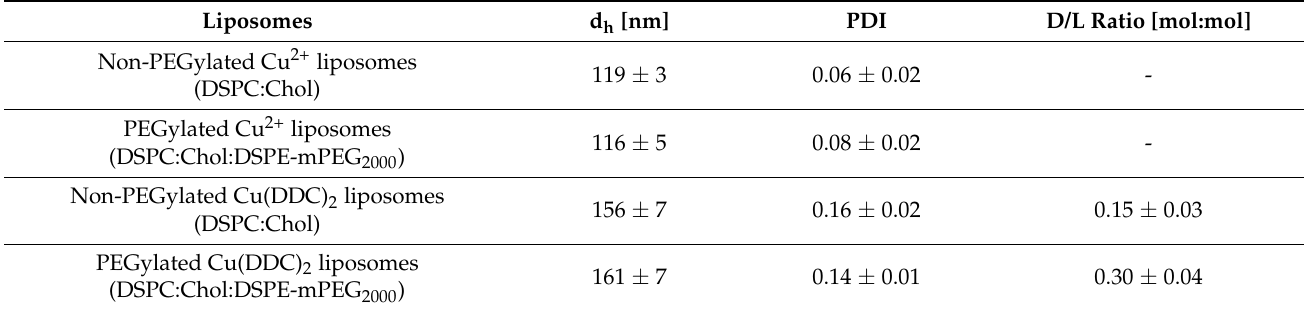
Table 1. Hydrodynamic diameter (d h ), polydispersity index (PDI), and D/L ratio of prepared liposomes. Data are ex- pressed as the mean ± SD ( n = 7).